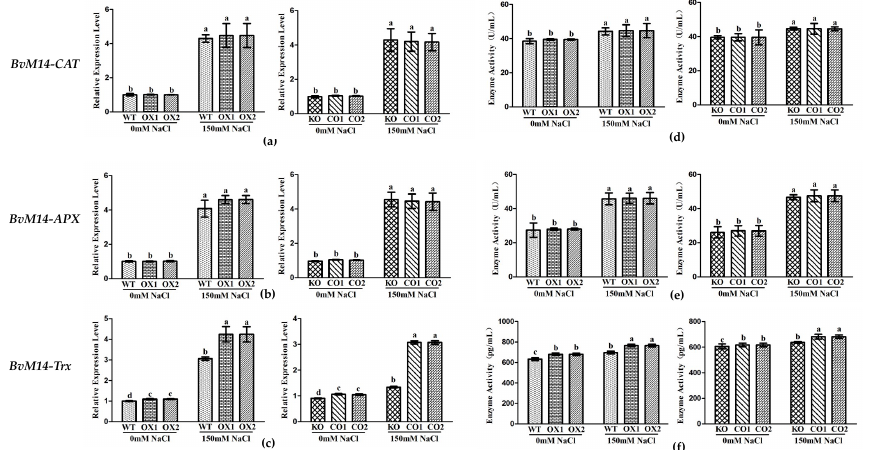
Figure 6. Analyses of relative gene expression and enzyme activities in PrxR -related plants under salt stress: ( a – c ) Analysis of the expression of antioxidative genes ( BvM14-CAT , BvM14-APX , and BvM14- Trx ) in WT and PrxR -related plants under salt stress; ( d – f ) antioxidant enzyme activity (BvM14-CAT, BvM14-APX, and BvM14-Trx) in WT and PrxR -related plants under salt stress. Data were analyzed by Duncan’s analysis of variance, and different lowercase letters (a, b, c, d) indicate differences in gene expression and enzyme activities.